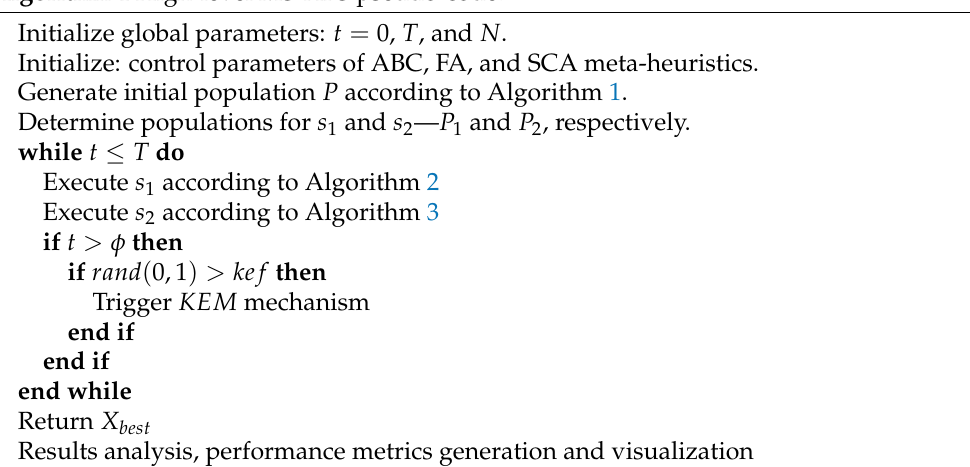
Algorithm 4 High-level MS-AFS